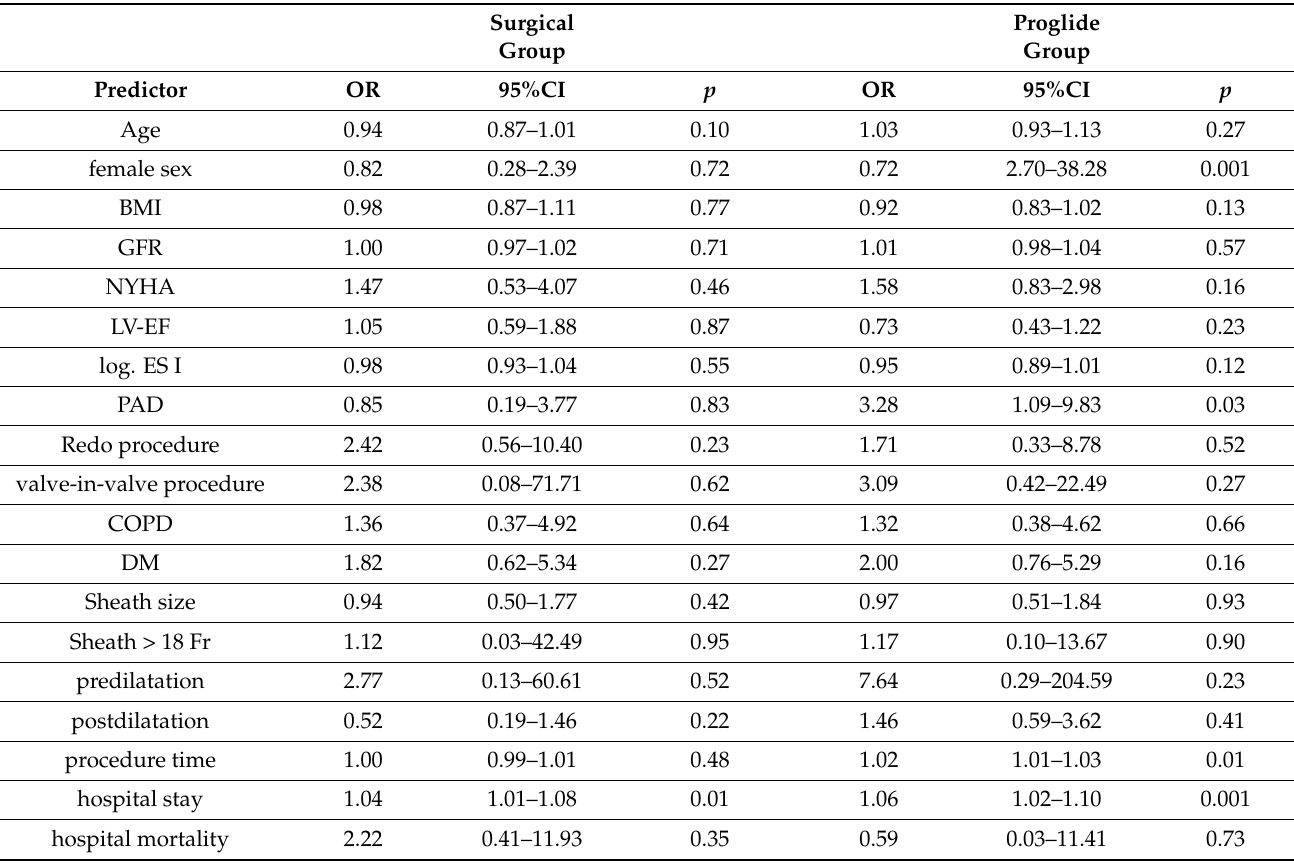
Table 4. Predictors of occurrence of the combined primary endpoint in the surgical and ProGlide groups.